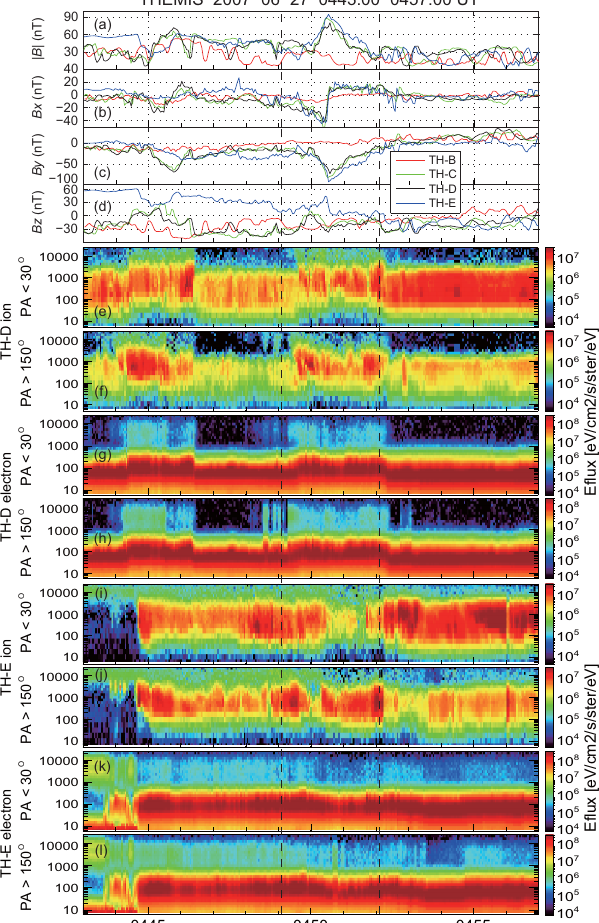
Figure 8. (a–d) Magnetic field measurements by the four THEMIS probes, and (e–l) energy-versus-time spectrograms of ions and elec- trons detected by the THD and THE probes. PA stands for the “pitch-angle” in the spacecraft frame of particles in question, and thus the upper and lower panels in each set of the two ion or electron spectrograms show the differential energy fluxes of field-aligned and anti-field-aligned particles, respectively. The reconstruction in- terval is sandwiched between the two vertical dashed lines.